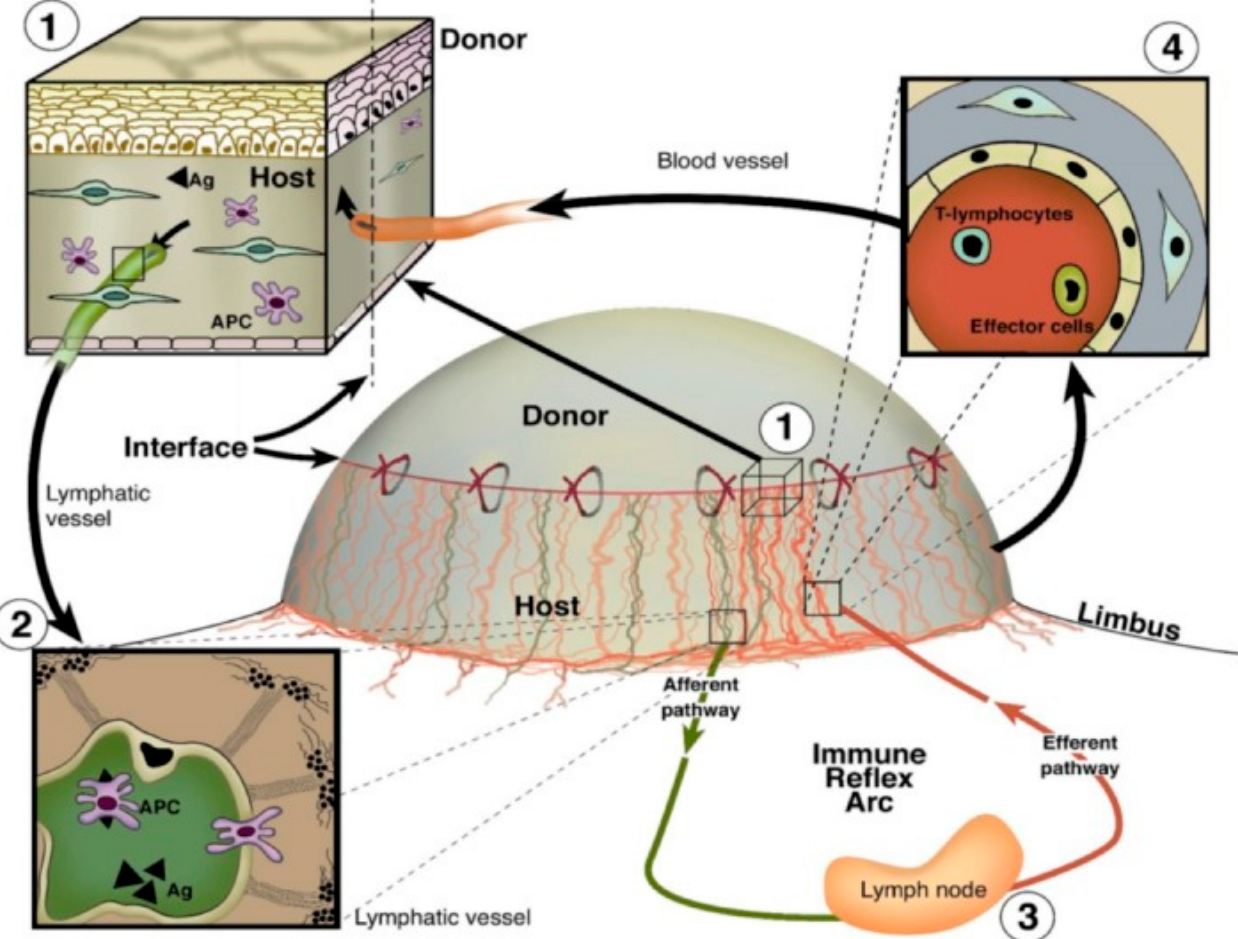
Figure 5. Blood and lymphatic vessel function in the afferent and efferent arms of inflammatory corneal neovascularization following corneal transplantation. ( 1 ) Antigens and antigen-presenting cells (APCs) surround the transplant surface ( 2 ) and enter afferent lymphatic vessels to migrate towards regional lymph nodes. ( 3 ) Activation of T lymphocytes and effector cells occurs ( 4 ), and these cells are transported back to the site of injury via efferent blood vessels [179]. Reproduced with permission.